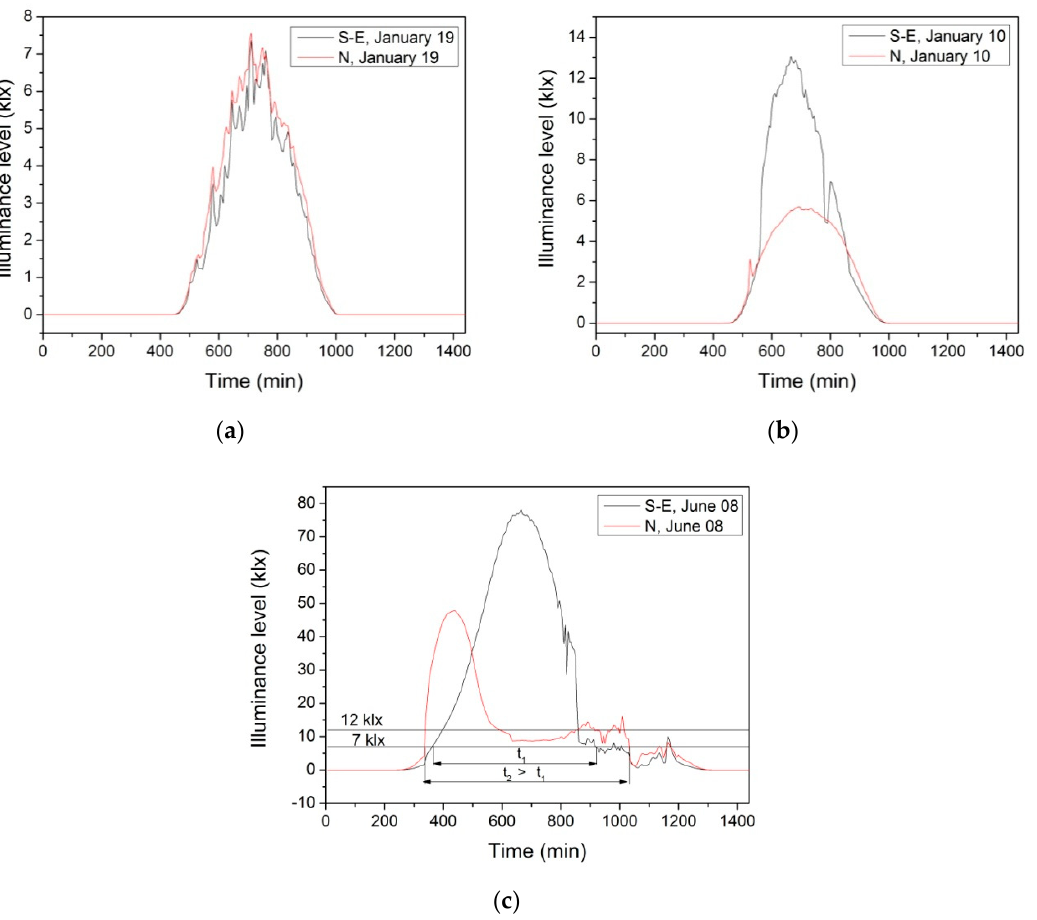
Figure 6. Illuminance levels of daylight measured by sensors located on the south-east (S-E) and north (N) side of the building in winter on an overcast day ( a ) and on a sunny day ( b ), as well as in the summer, on a sunny day ( c ).